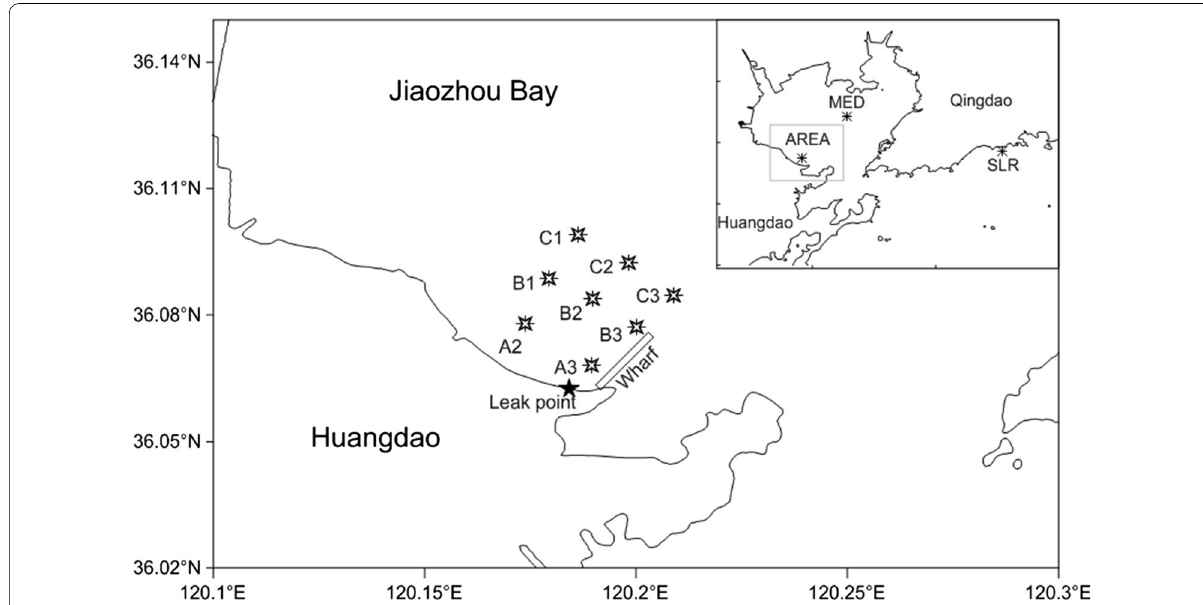
Fig. 1 Map of the sediment sampling sites in Jiaozhou Bay. The symbol filled black star identifies the location of the leak point, and identifies the sampling sites. A, B and C were the three sampling sections and were parallel to the shoreline. The sampling sites were designated with a line name and number, e.g., B1, B2 and B3 were the sites in line B. Eight of the ten sites were located near the leak point. The sites MED and SLR were chosen as control sites on the other side of Jiaozhou Bay and Shilaoren